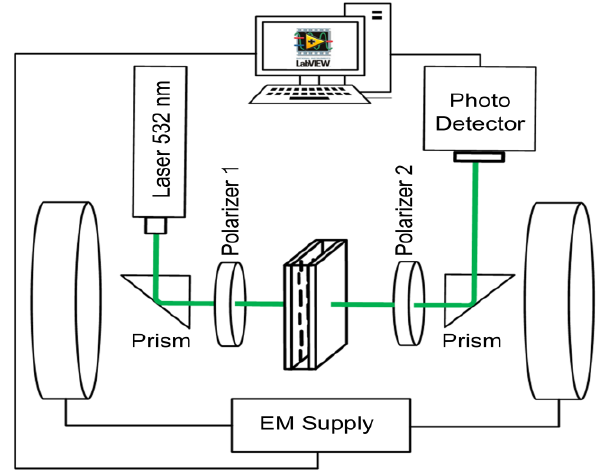
Figure 2. Experimental arrangement for magneto-optical investigation.